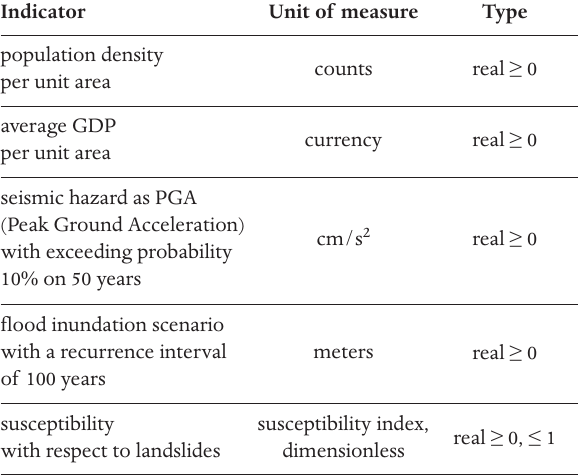
Table 1. Examples of vulnerability and risk-related